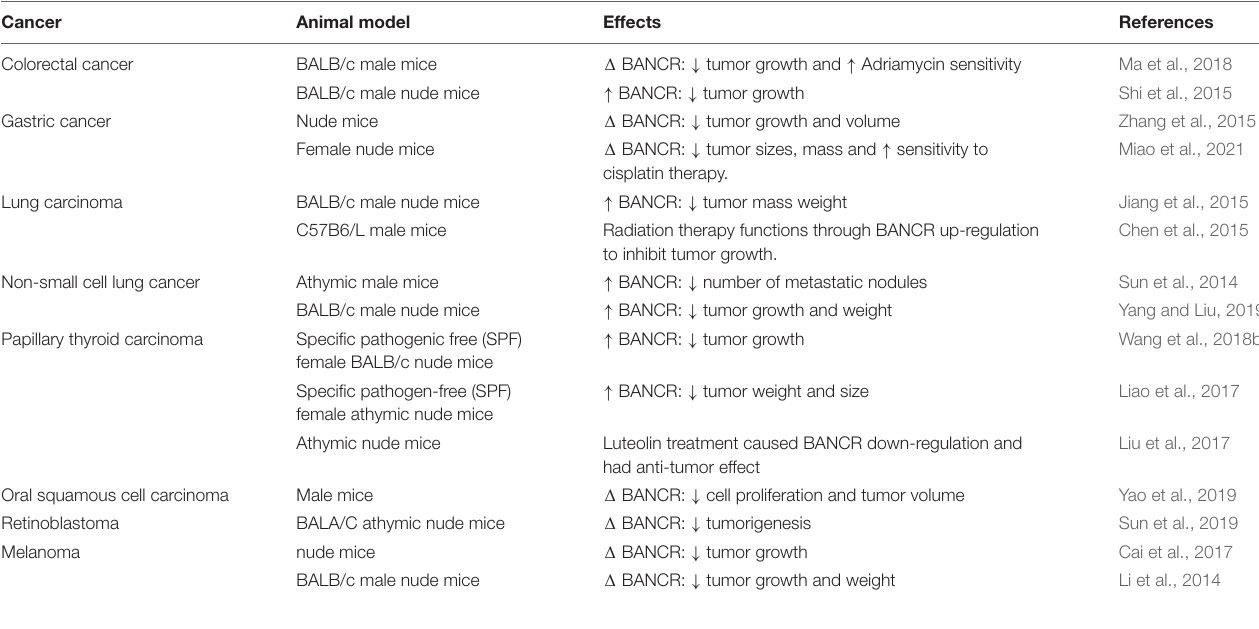
TABLE 1 | Consequences of BANCR up-/down-regulation in animal models of cancer.